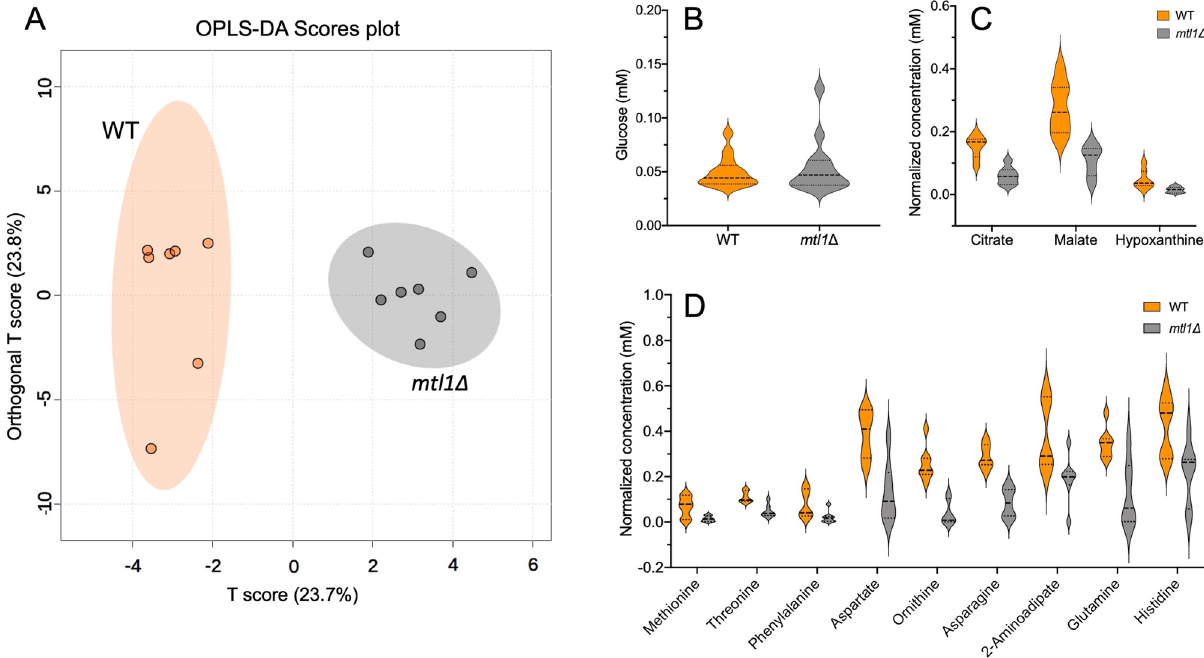
Figure 2. Metabolomics analysis of WT and mtl1 Δ strains. ( A ) OPLS-DA score plot based on WT and mtl1 Δ cell metabolomes. ( B ) Violin plots visualize the non-significant distribution of glucose in WT and mtl1 Δ strains (n = 12). ( C–E ) Violin plots visualize the distribution of significantly altered metabolites in WT and mtl1 Δ strains (n =